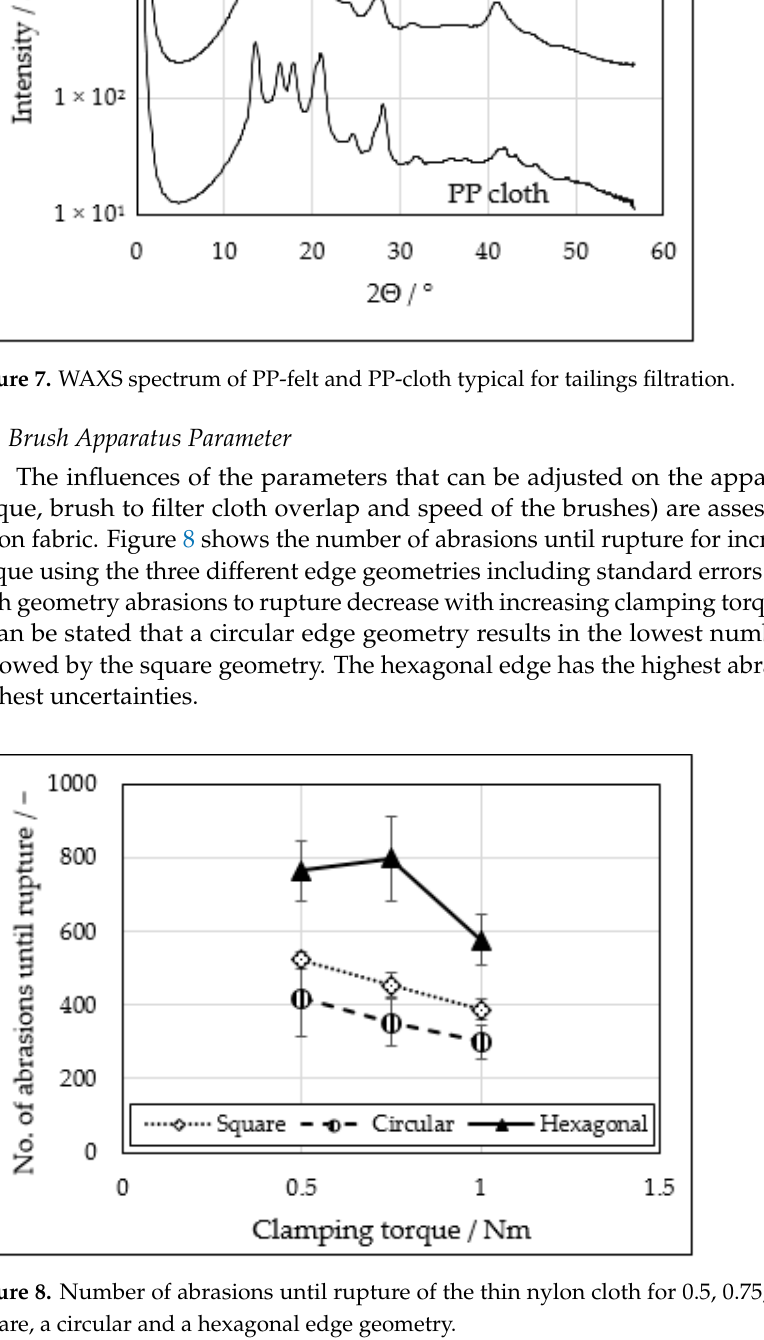
Figure 6. WAXS spectrum of thin NY-cloth and NY-cloth typical for tailings filtration.